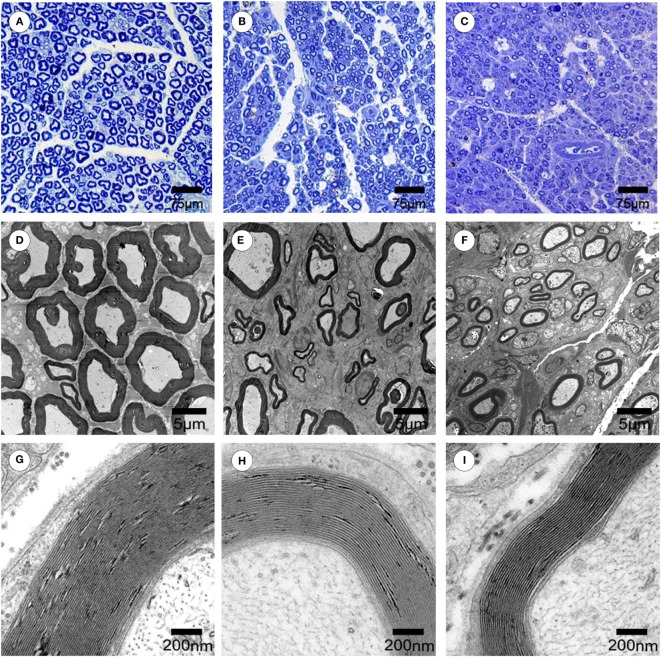
Morphological appearance of regenerated nerves in each group. The representative toluidine blue staining of regenerated axons (A–C) in the midst of conduit in the DPEMF group (A), NPEMF group (B), and CF group (C) at 12 weeks after surgery, respectively. The representative electron micrographs of regenerated axons (D–F) and myelin sheath (G–I) in the midst of conduit in the DPEMF group (D,G), NPEMF group (E,H), and CF group (F,I) at 12 weeks postoperatively.